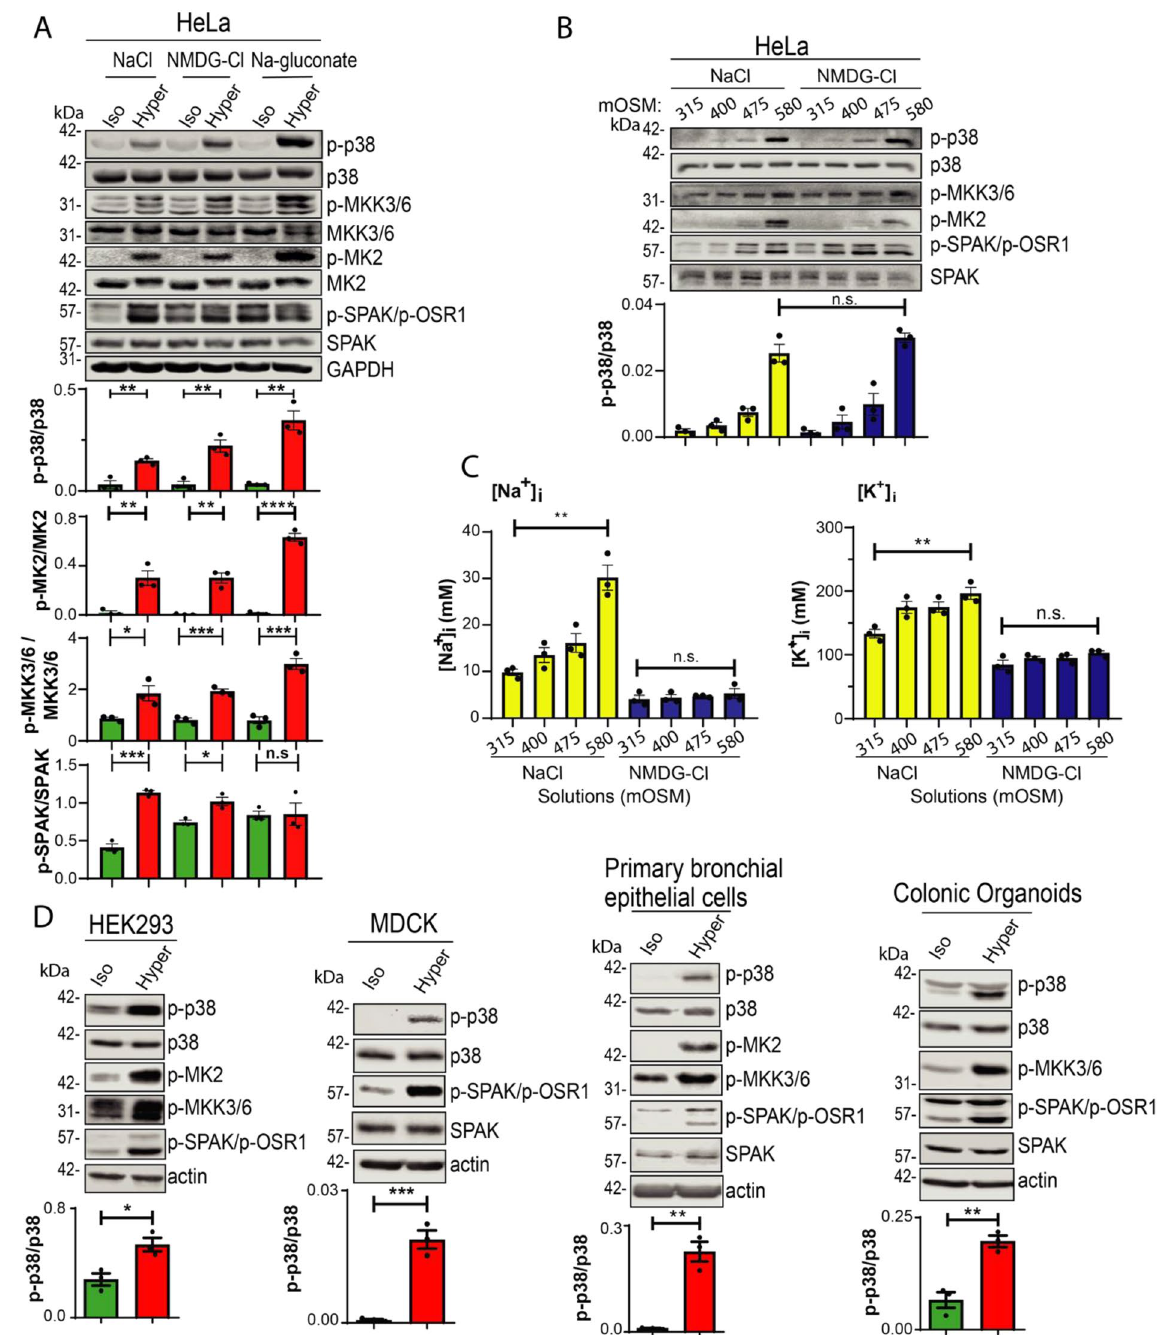
Figure 1. p38 is activated following hyperosmotic treatment. ( A ) HeLa cells were treated with 315 mOSM Iso-osmotic (Iso) or 580 mOSM Hyper-osmotic (Hyper) solutions of NaCl, NMDG-Cl − or Na + -gluconate for 15 min. ( B ) HeLa cells were treated with either NaCl or NMDG-Cl − solutions with increasing osmotic concentrations, as indicated. ( C ) Quantitation of intracellular Na + or K + concentration ([Na + ] i and [K + ] i ) in HeLa cells following treatment with either NaCl or NMDG-Cl − solutions with escalating osmotic concentrations. ( D ) HEK293, MDCK, Human Primary Bronchial Epithelial cells or mouse Colonic Organoids were treated with iso-osmotic or hyper-osmotic NaCl for 15 min. Quantification of active (phosphorylated) p38 (p-p38), MK2 (p-MK2) or MKK3,6 (p-MKK3/6) relative to their respective total proteins is depicted below their respective blots. All data are mean ± s.e.m, N = 3 independent experiments, p -values: Not significant (n.s.) > 0.05; * < 0.05; ** < 0.01; *** < 0.001; **** < 0.0001. p -value were calculated using Student’s t